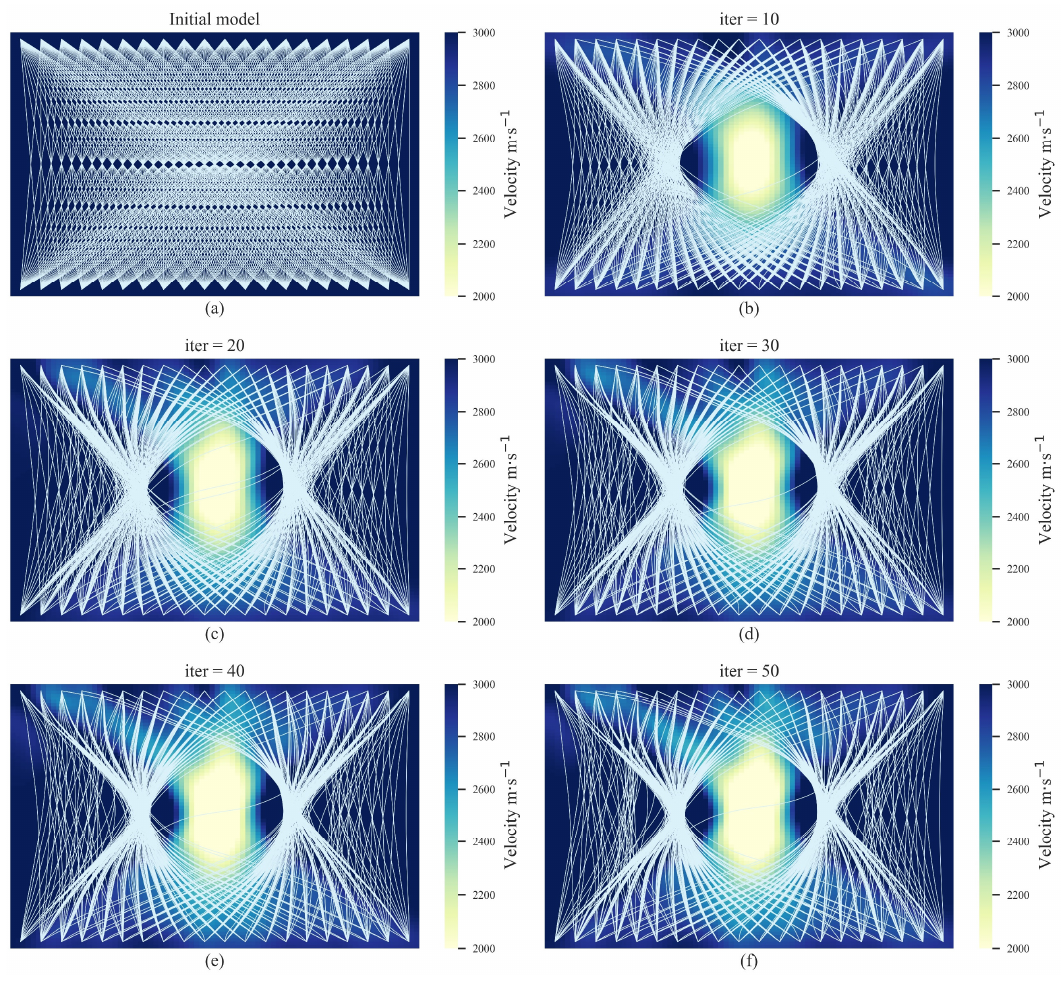
Figure 3. The iteration results for AE tomography in the numerical experiments for the single cavity damage source. ( a – f ) show the iteration results from the initial model to the 50th iteration.